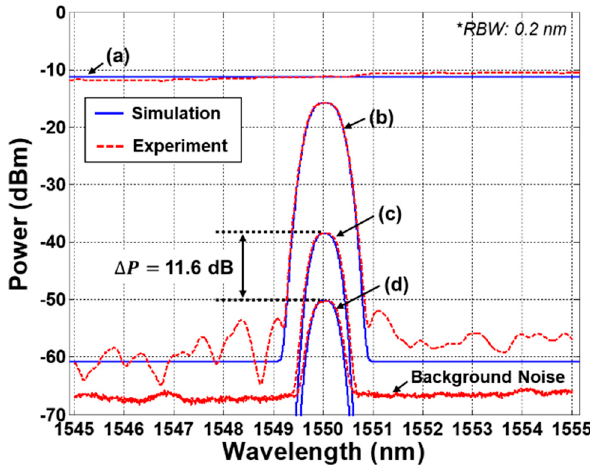
Figure 2. Simulated and measured optical spectra of the spectrum-sliced amplified spontaneous emission (ASE) according to the Fresnel reflection. ( a ) ASE, ( b ) spectrum-sliced ASE, ( c ) spectrum-sliced ASE reflected at the air, and ( d ) spectrum-sliced ASE reflected at the water.